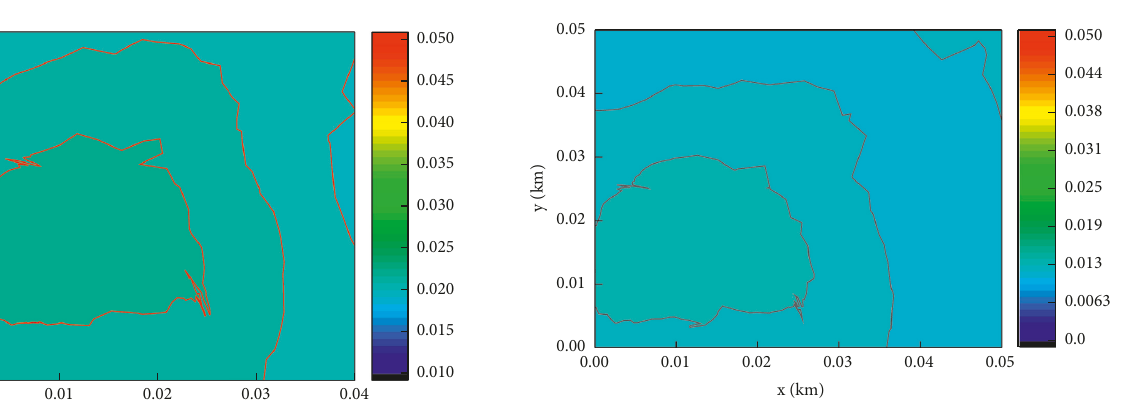
Figure 5: The prediction error distribution of Hanfu color features.